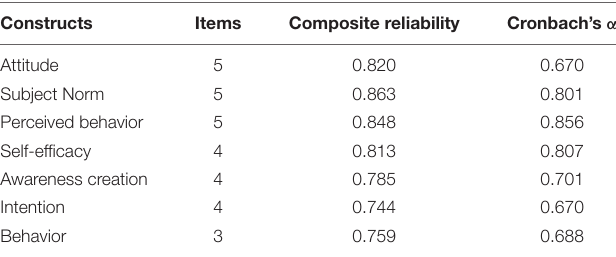
TABLE 3 | Composite reliability and Cronbach’s α of constructs.